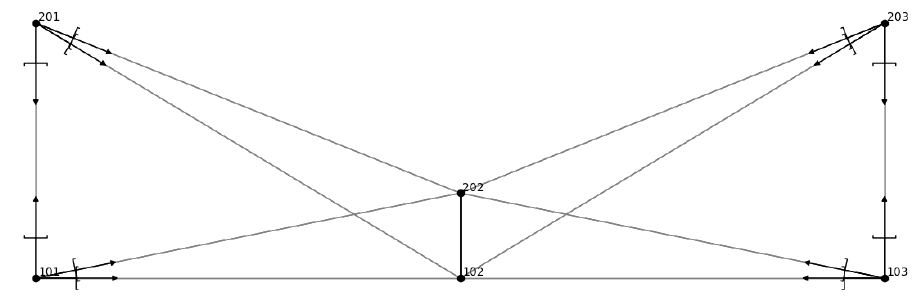
Figure 2. Six-points control network segment.